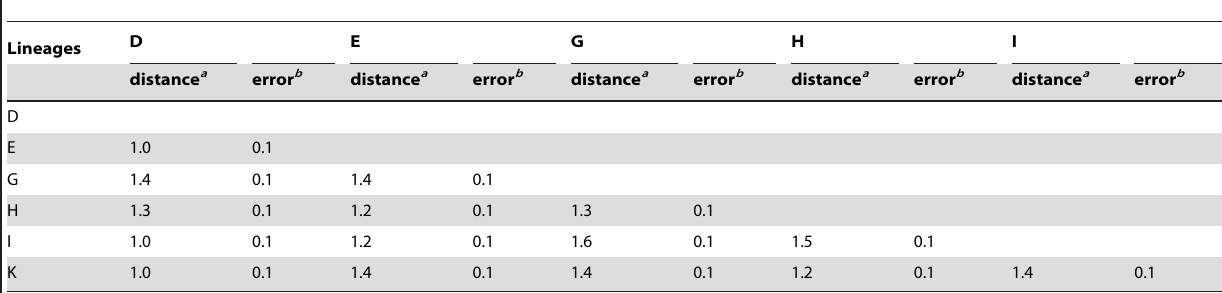
Table 1. Mean genetic divergence between lineages.